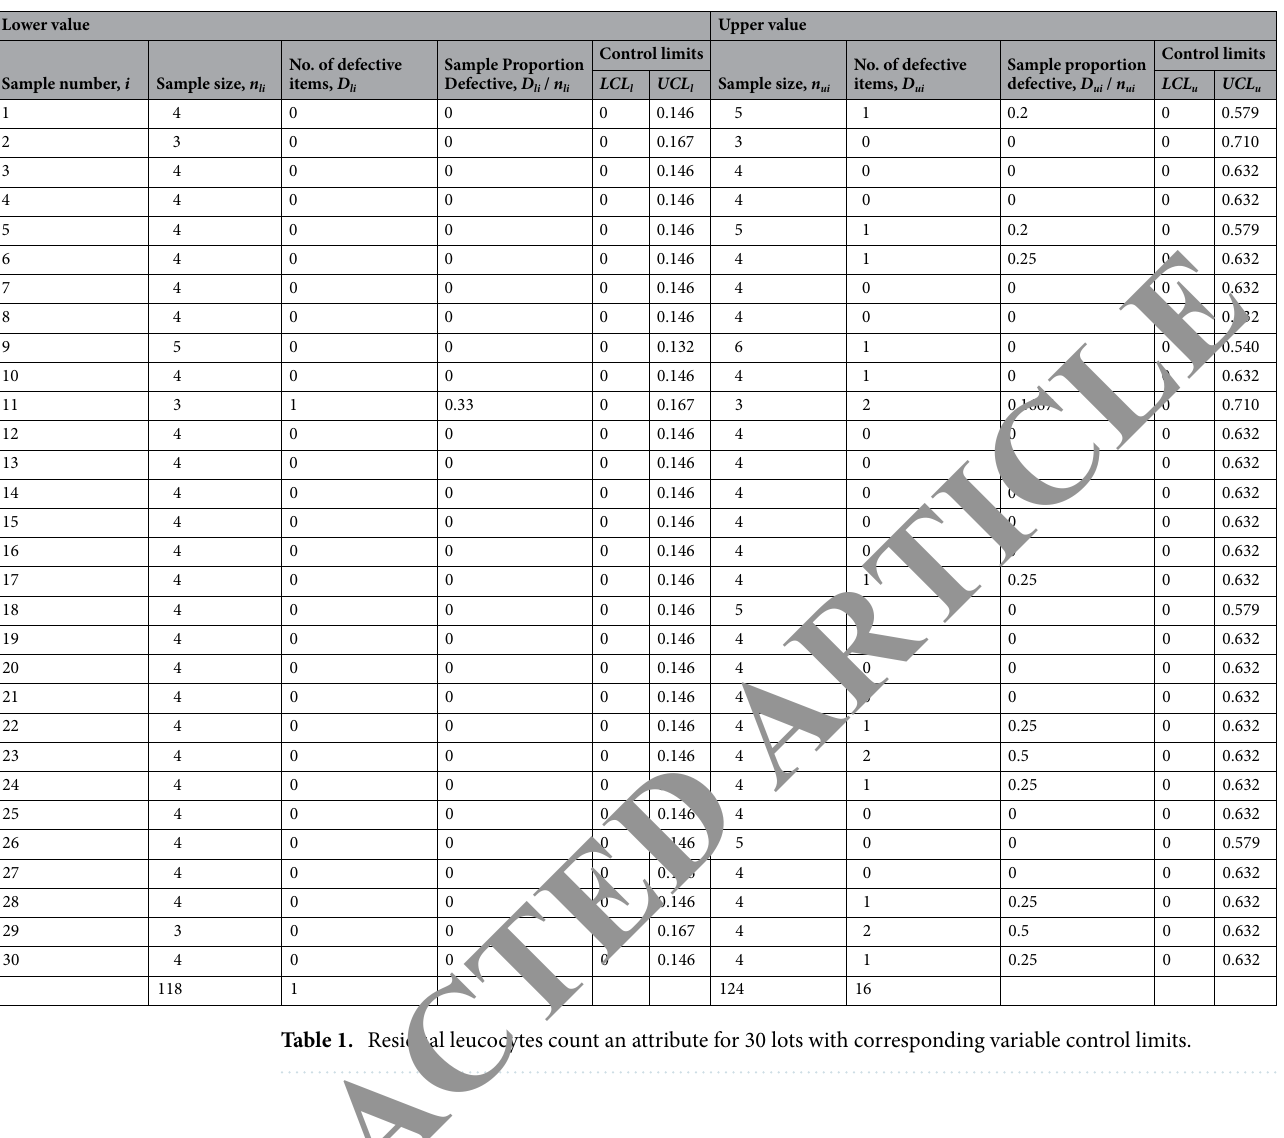
Table 1. Residual leucocytes count an attribute for 30 lots with corresponding variable control